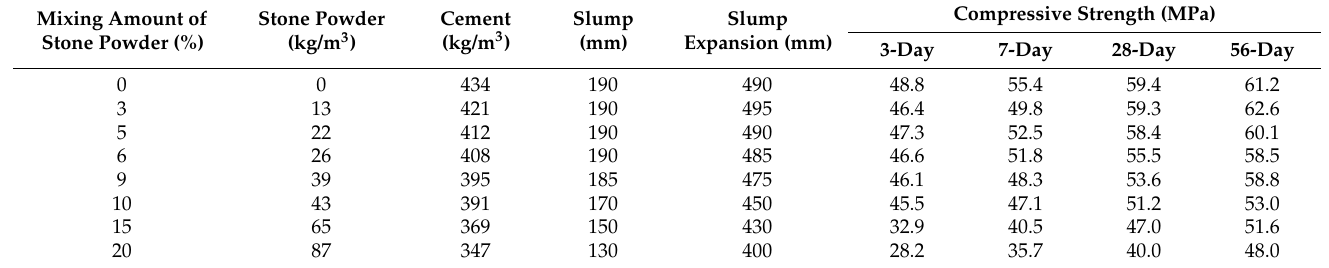
Table 9. Results of concrete performance tests of stone powder replacing the equivalent amount of cement.